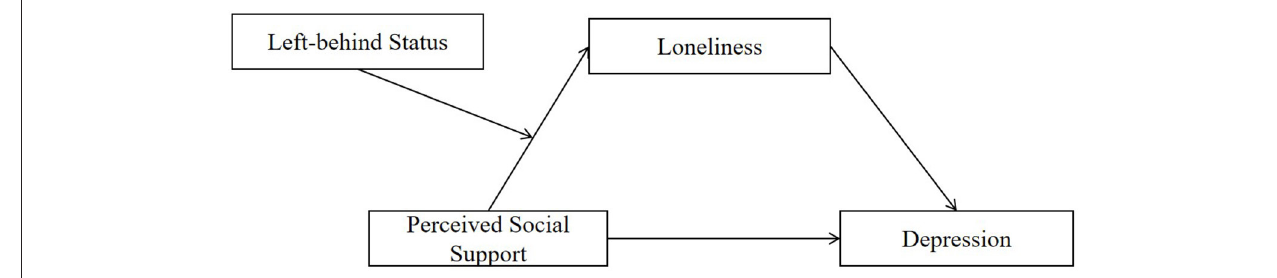
FIGURE 1 | Conceptual